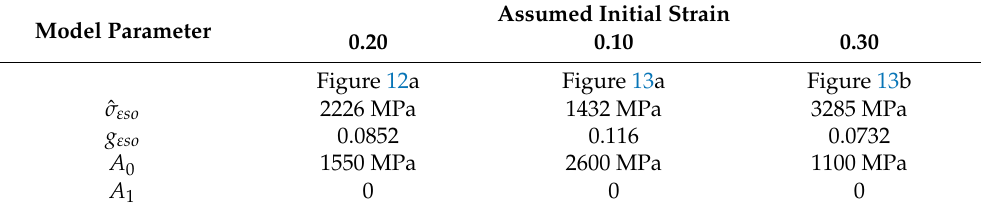
Table 5 lists the evolution law model parameters for all three assumed initial strains. The assumed initial strain has a large impact on these model parameters. Table 5. Evolution model parameters for the three assumed initial